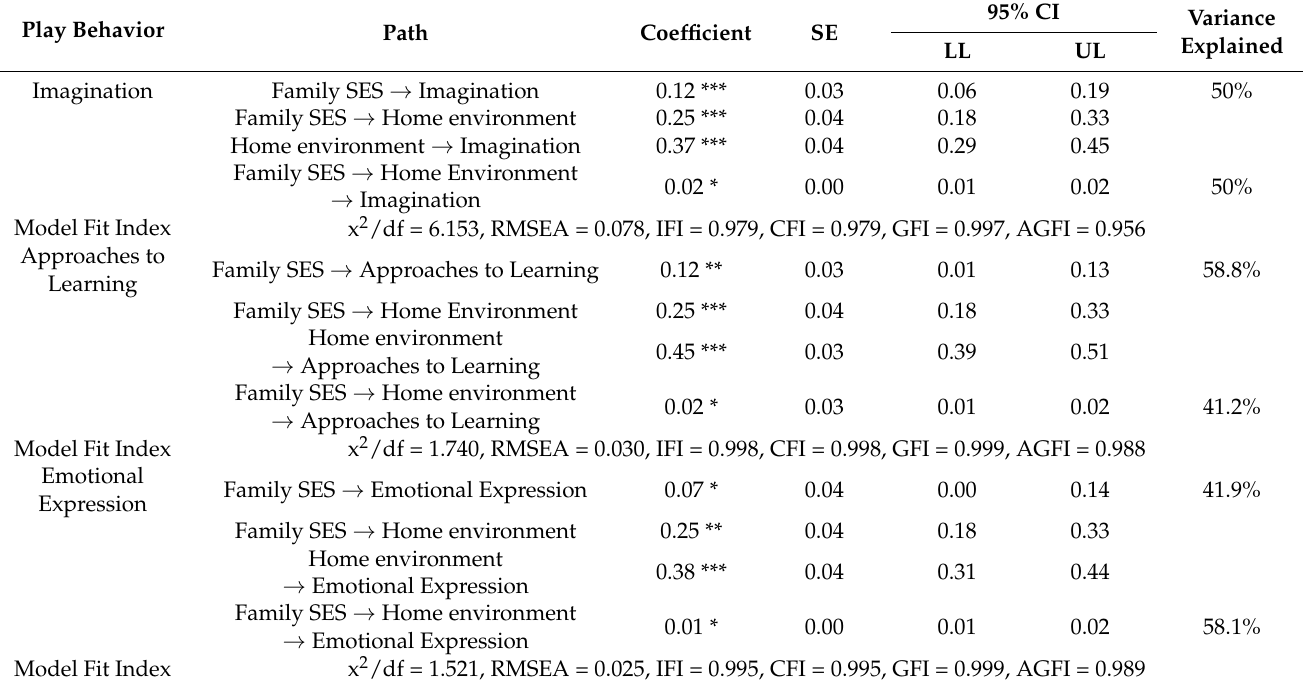
Table 4. Mediating Models Linking Family SES, Home Environment, and Children’s Play